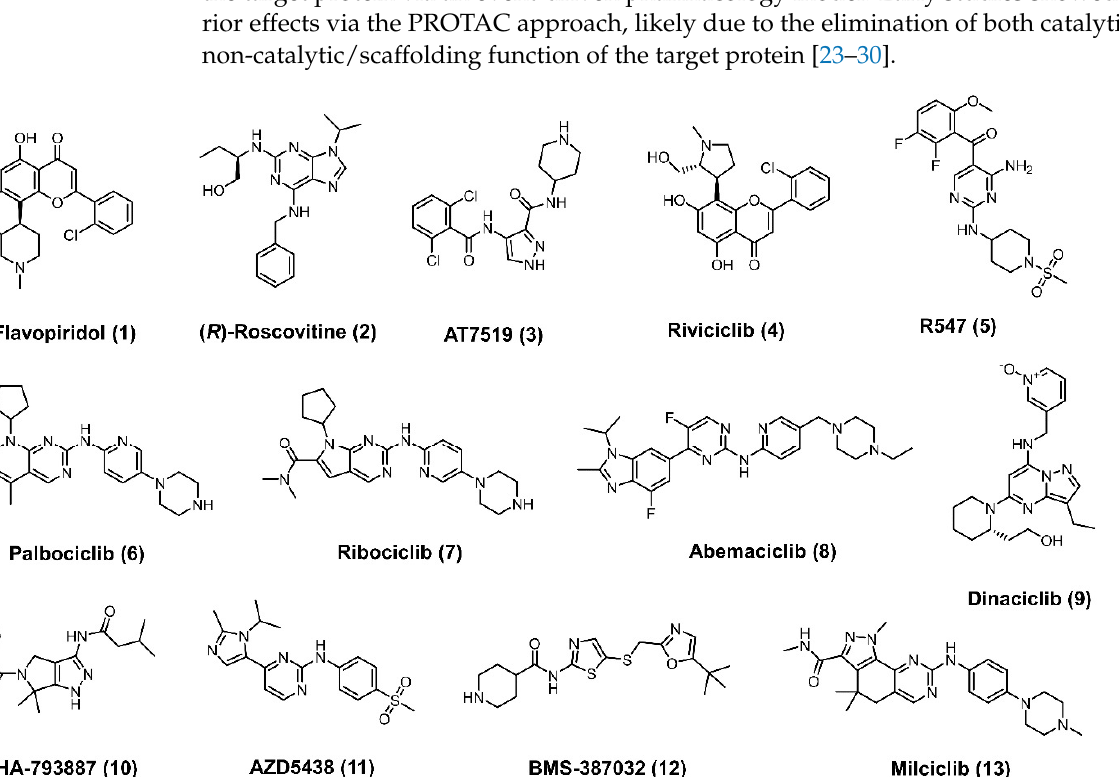
Figure 1. CDK inhibitors that are advanced to the clinic/clinical trials. Table 1. CDK inhibitors in clinical trials.